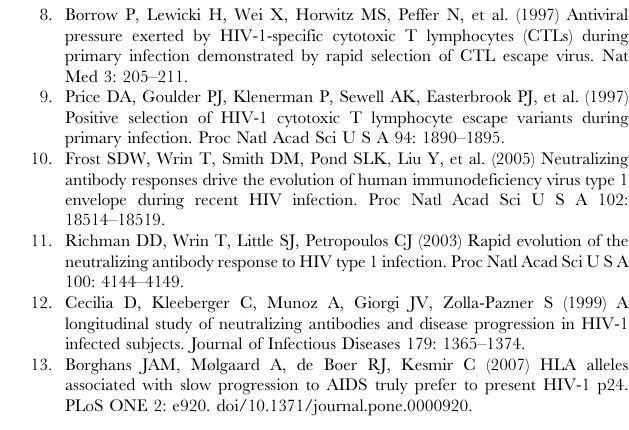
Figure S1 Amino acid toggling and tree shape. Toggling was simulated either (A) along a random tree in which branch lengths were drawn from an exponential distribution (mean =0.05), or (B) along an HIV-1 tree estimated from published nef sequence data [4]. Figure S2 Effect of tree shape on power to detect positive selection. Simulated data was used to construct ROC plots of the effects of tree shape on performance of both models. (A) Diversifying selection. (B) Positive selection (diversifying selection and toggling). (C) Amino acid toggling only.